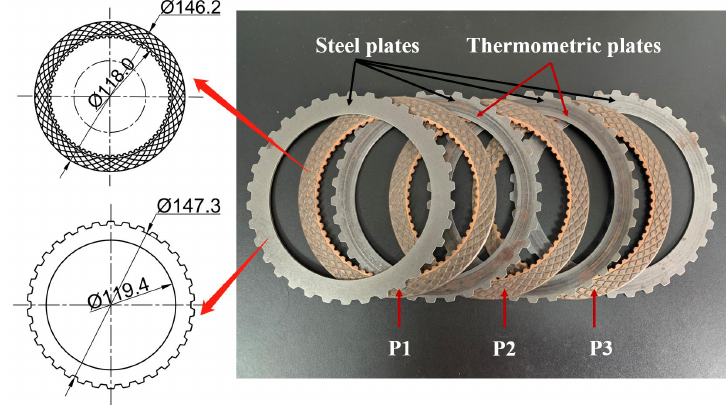
Figure 1. Dimensions of friction discs and steel plates. The spark plasma sintering processing technology is used to make the initial surfaces rough and porous to maintain a certain COF. The manufacturing process of the test sample is shown in Figure 2. As shown in Figure 1, The CBFM-A and CBFM-B have the same construction dimensions whose inner and outer diameters are 118.0 and 146.2 mm, respec- tively. The bisecting double-helical grooves, accounting for around 50% of the disc area, are designed in contact with the surface to guild oil and dissipate heat. The groove depth is about 0.3 mm, and 1.5 mm in width. The inner and outer diameters of the steel plate are 119.4 mm and 147.3 mm, respectively.